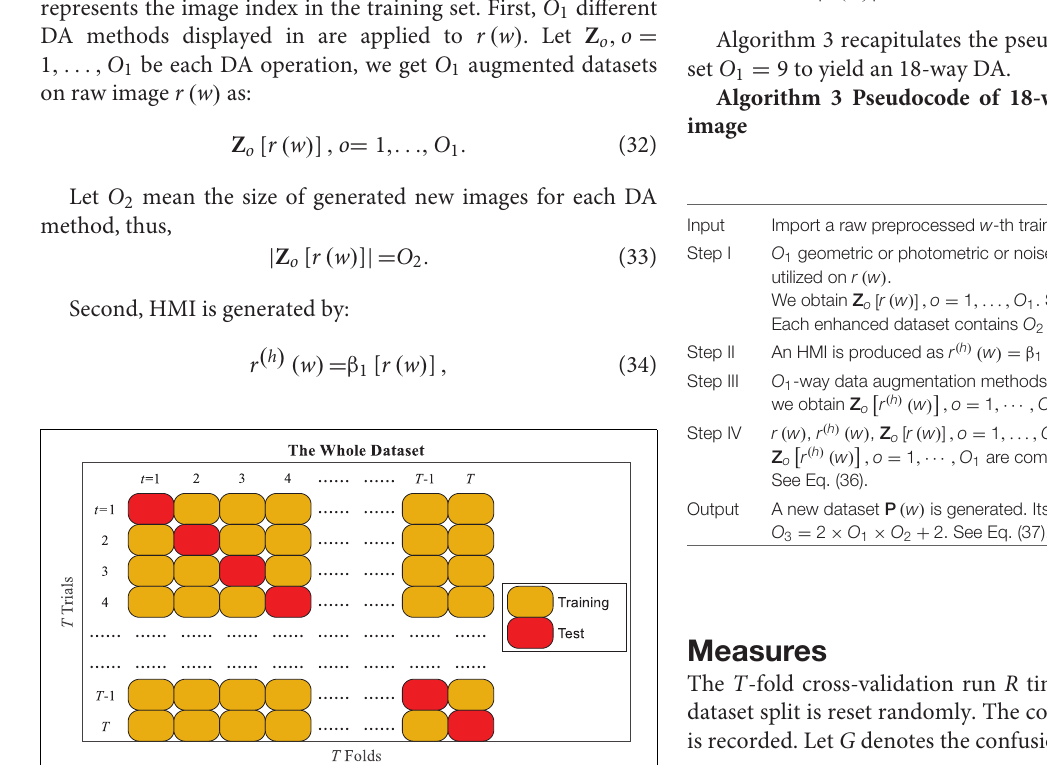
FIGURE 8 | Diagram of T -fold cross-validation.